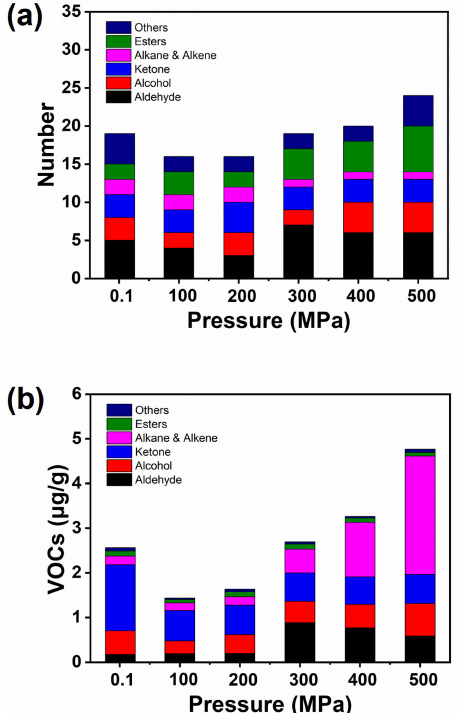
Figure 2. Change of the number ( a ) and total content ( b ) of volatile flavor components in oysters treated with different